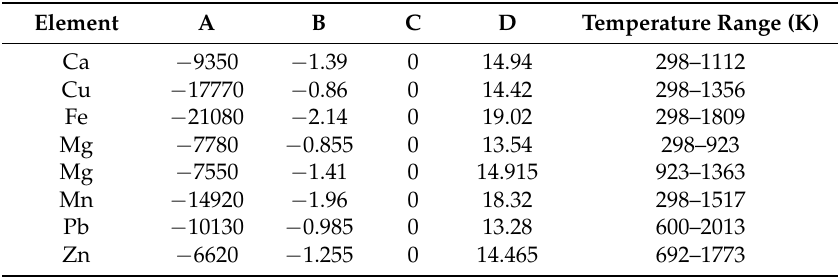
Table 1. Values of evaporation constants for Mg and its typical impurities